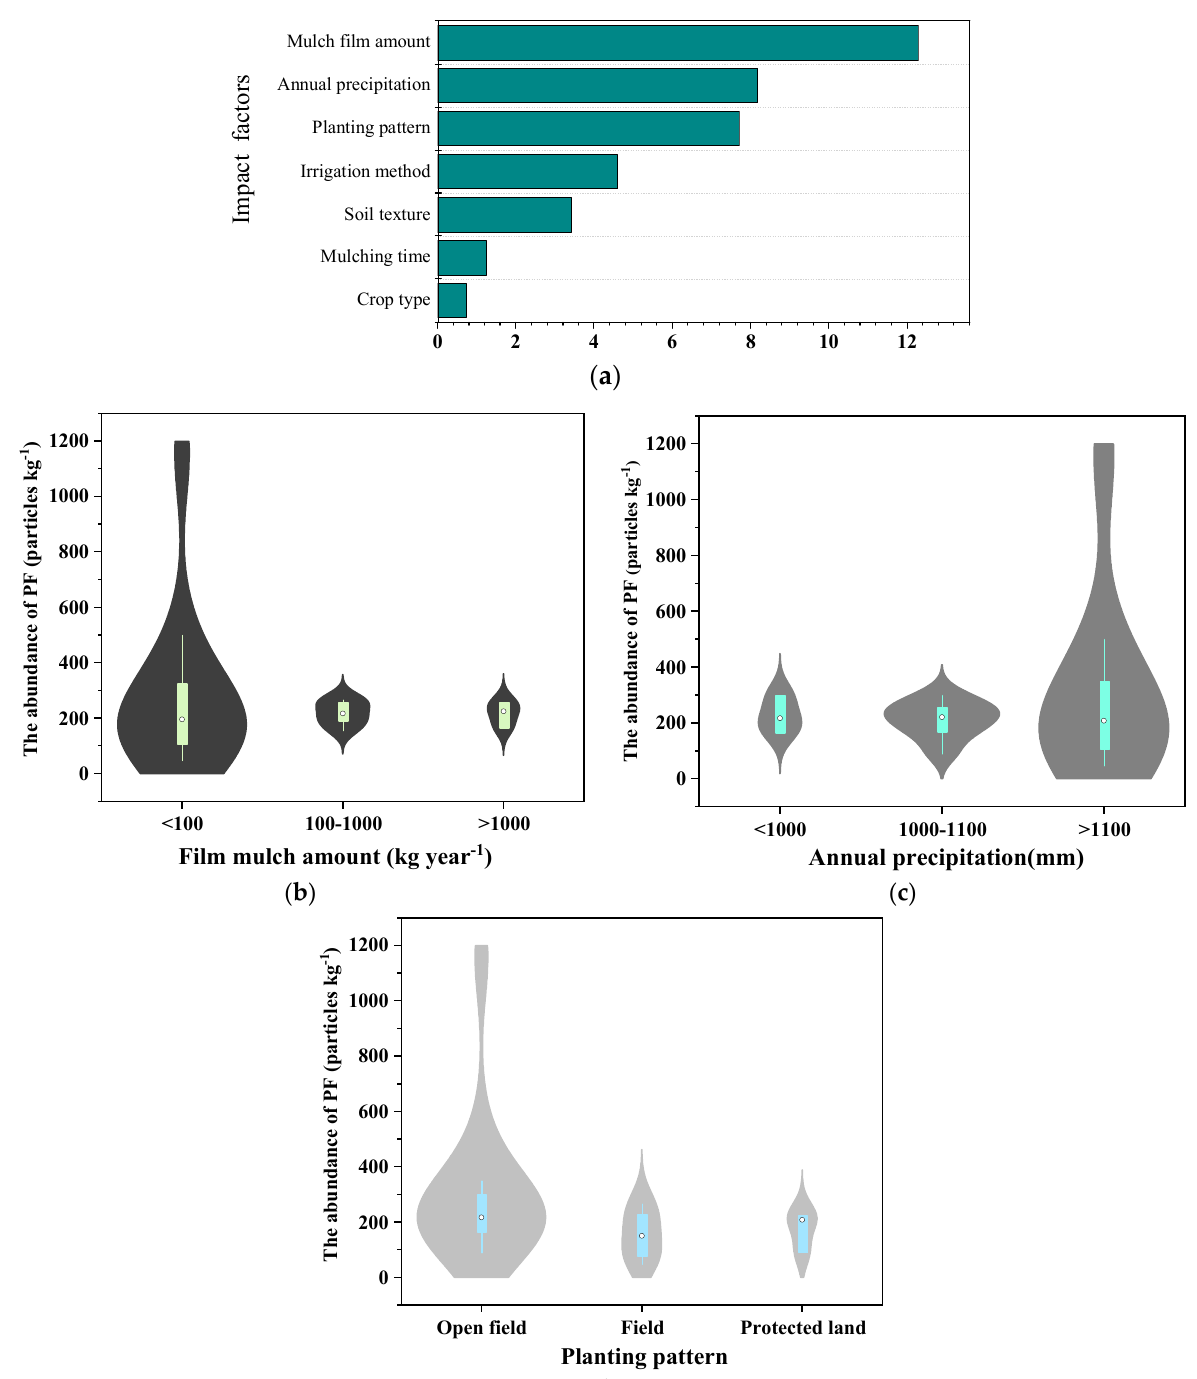
Figure 6. Influence of factors on PF in sampling sites. ( a ) Random-forest map of factors affecting PF; ( b ) Effect of film mulch amount on the PF; ( c ) Effect of annual precipitation on the PF; ( d ) Effect of planting pattern on the PF.